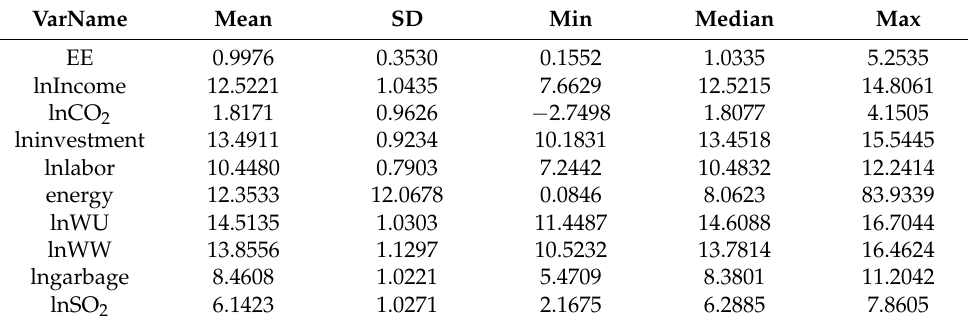
Table 2. Statistical characteristics of driving